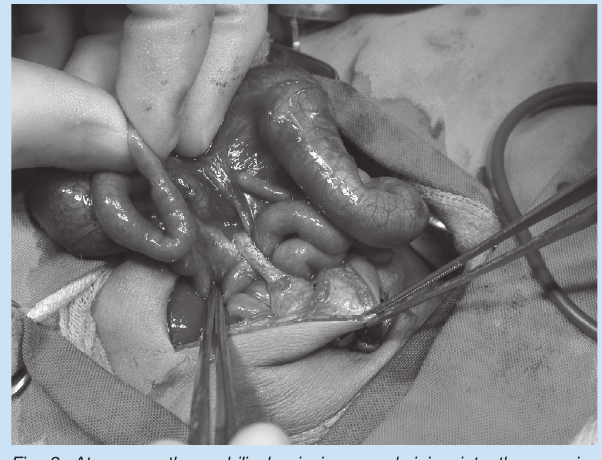
Fig. 2. At surgery the umbilical vein is seen draining into the superior mesenteric